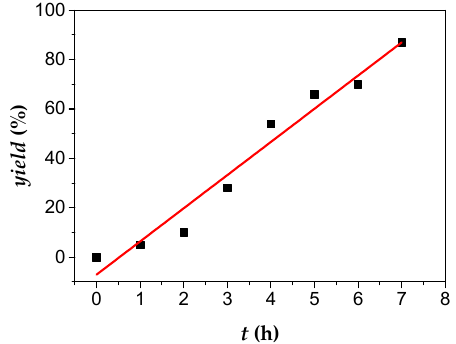
Figure 6. Polymerization of VNBE (4.9 mL, 4.1 g, 34.0 mmol) with 1 (30 mg, 0.017 mmol), AgBF 4 (13.2 mg, 0.068 mmol) and 2 mL CH 2 Cl 2 ; % yield vs. time plot of PVNBE.